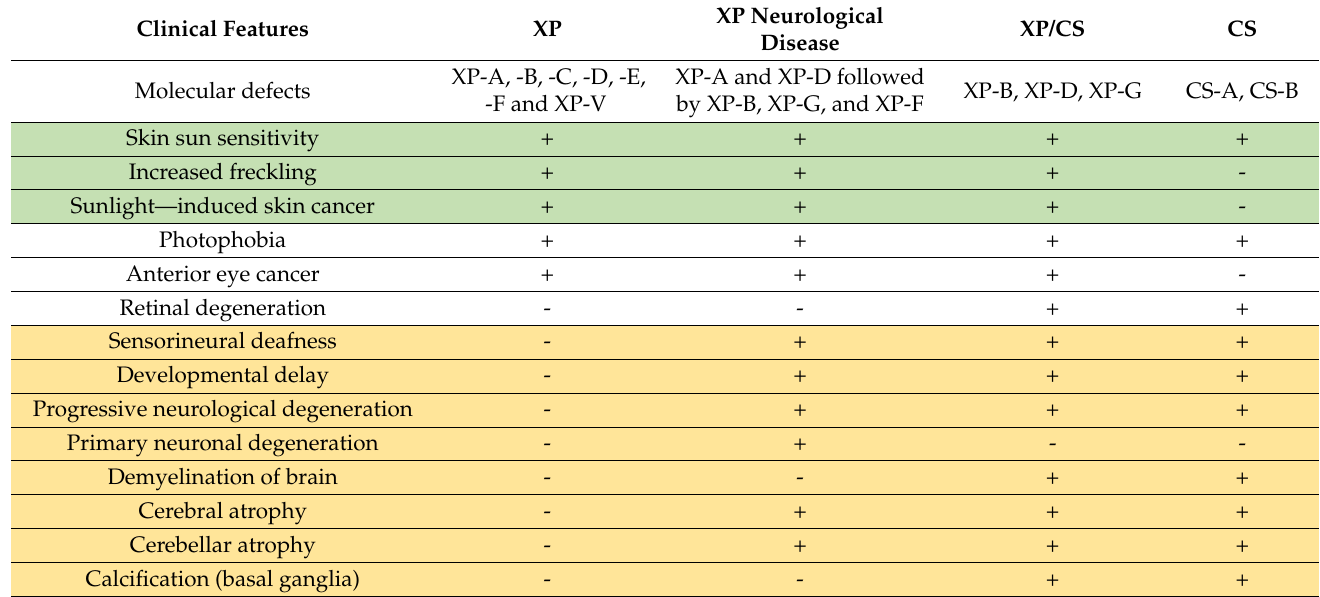
Table 1. Comparison of clinical features of patients with XP, XP neurological disease, XP/CS, and CS [11,12]. Clinical